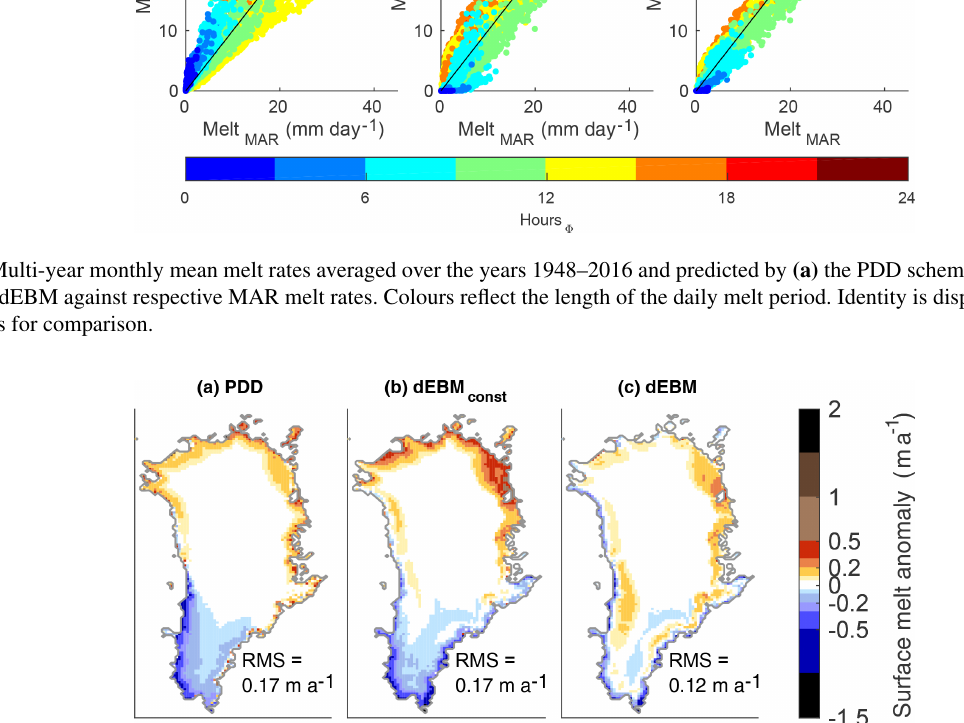
Figure 3. Bias between yearly melt rates predicted by the individual schemes and simulated by MAR, averaged over the whole simula- tion: (a) PDD, (b) dEBM const and (c) the proposed new scheme dEBM. The respective root mean square error (RMSE) is given in the individual